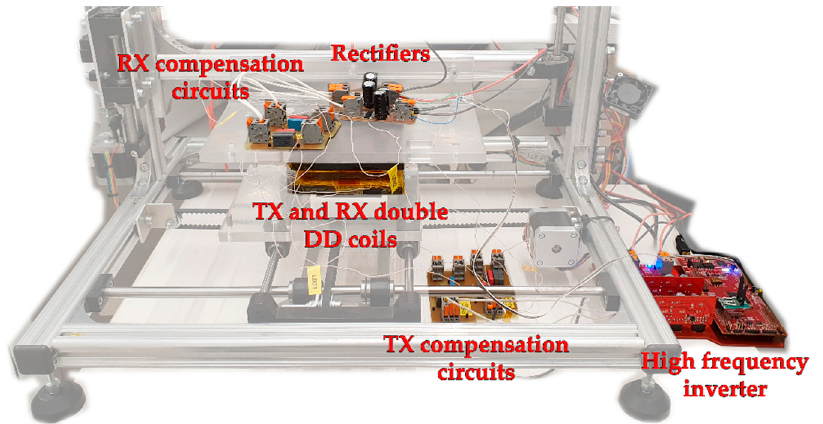
Figure 8. Small scale IPT system structure.